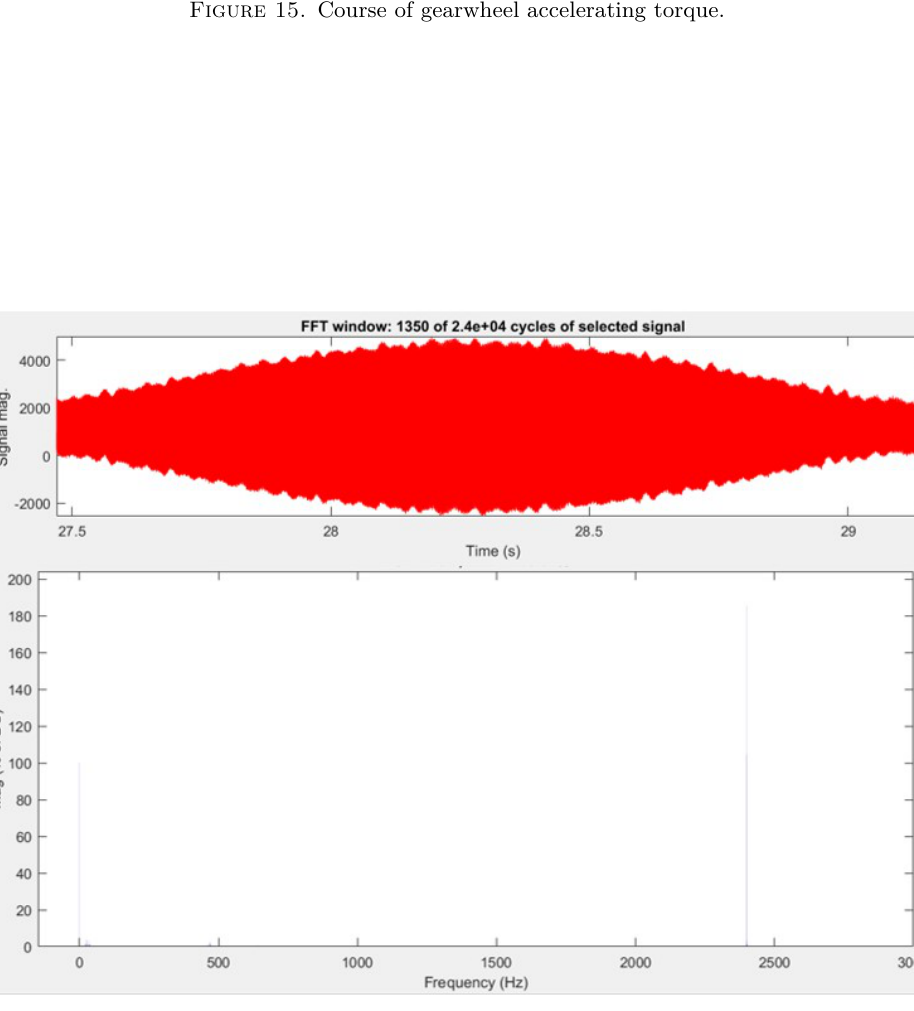
Figure 16. FFT analysis of the gearwheel accelerating